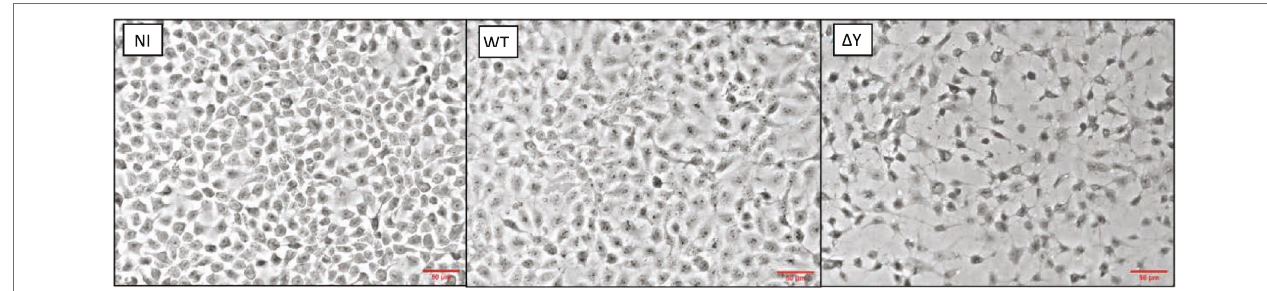
FIGURE 4 | Morphology of NCI-H292 human bronchial cells infected with P. aeruginosa wild-type strain PAO1F or the exoY deletion mutant. Shown are microscopic images (obtained using a 20x objective of a Nikon Eclipse 80i microscope equipped with a DS-U1 camera) of non-infected cells (NI), cells infected with WT or the ∆ Y mutant at an MOI of 20. Bacteria were removed 3 h post-infection and processed as detailed in Materials and Methods. The experiment was performed two times and the representative images are shown. Red lines indicate the scale of 50 μ